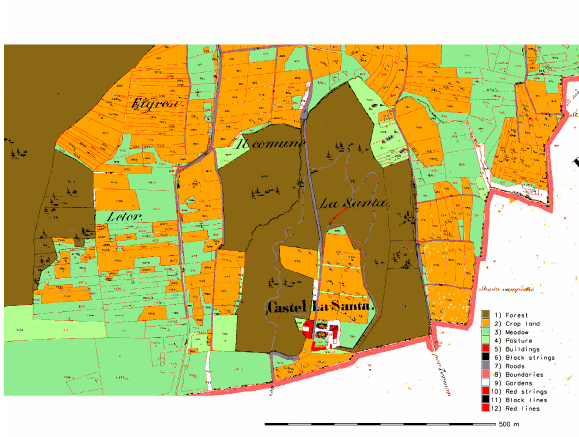
Figure 7. Classified map for OBIA and BWWV -